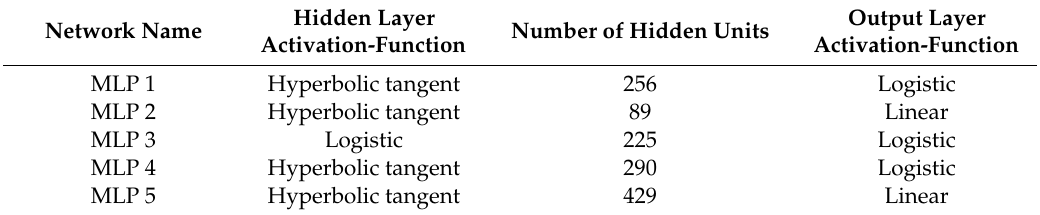
Table 7. Network configurations